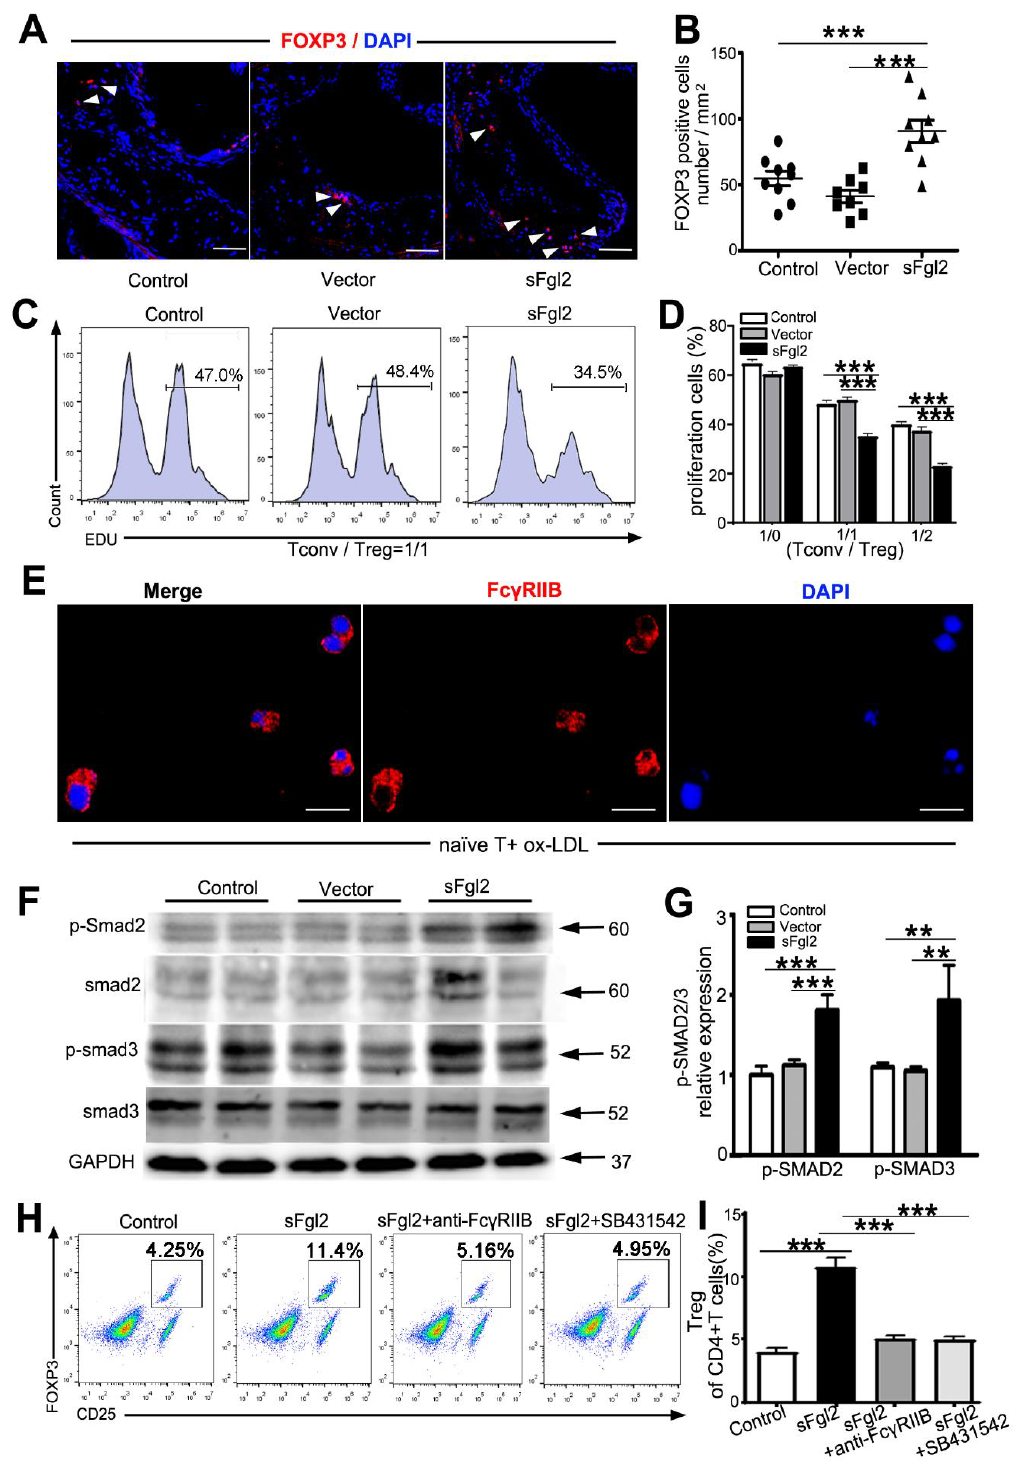
Figure 4. ( A ) Immunofluorescent staining and ( B ) quantification of Treg cells (Foxp3 + ) in the aortic root cross-sections of PBS-, Vector-AAV-, and sFgl2-AAV- tail-vein-injected ApoE -/- mice. Scale bar = 100 µ m. ( C ) Firstly, CD4+CD25- (T Conv ) cells from WT mice and CD4+CD25+ (Treg) cells from the above three groups of ApoE -/- mice were sorted by FACS. Then, the EDU-labeled T Conv cells were co-cultured with Treg cells at ratios of 1/0,1/1, and 1/2 on CD3/CD28 pre-incubated plates. Representative histograms for T Conv proliferation were shown. ( D ) Bars represent the percentage of proliferating T Conv cells (N = 3). ( E ) Naïve T cells were obtained from atherosclerotic ApoE -/- mice